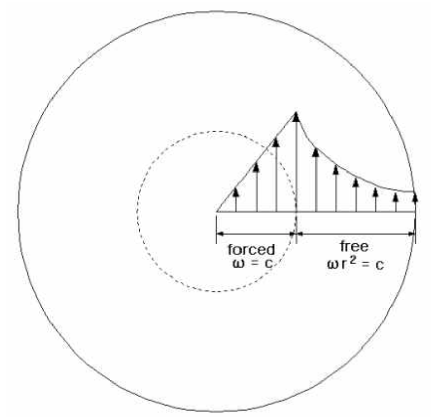
Figure 1. Cross ‐ section of the vortex tube in the “free” and “forced” vortex flow.